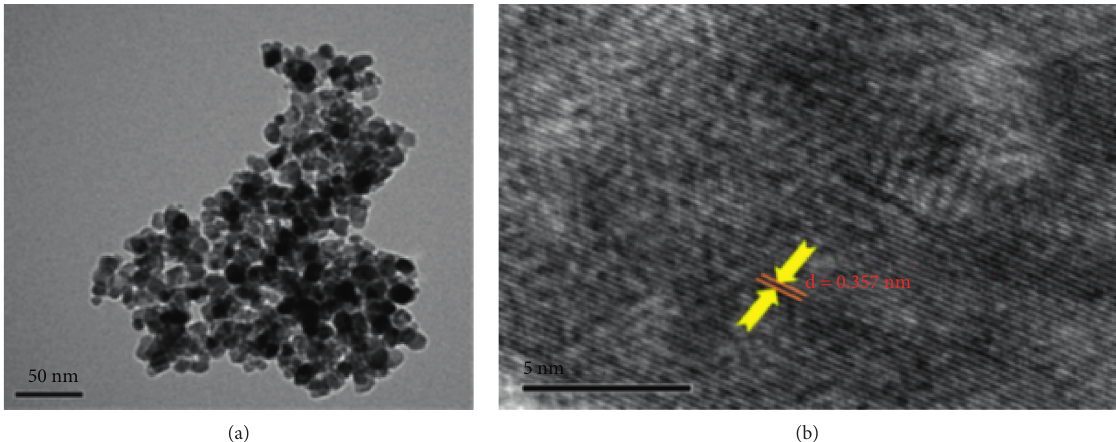
Figure 9: TEM micrograph of (a) Trigonella foenum graecum- and (b) Aloe vera -mediated synthesized TiO